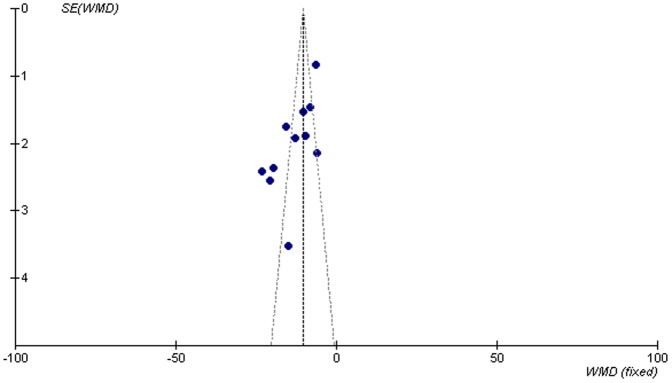
FIQ funnel diagram.